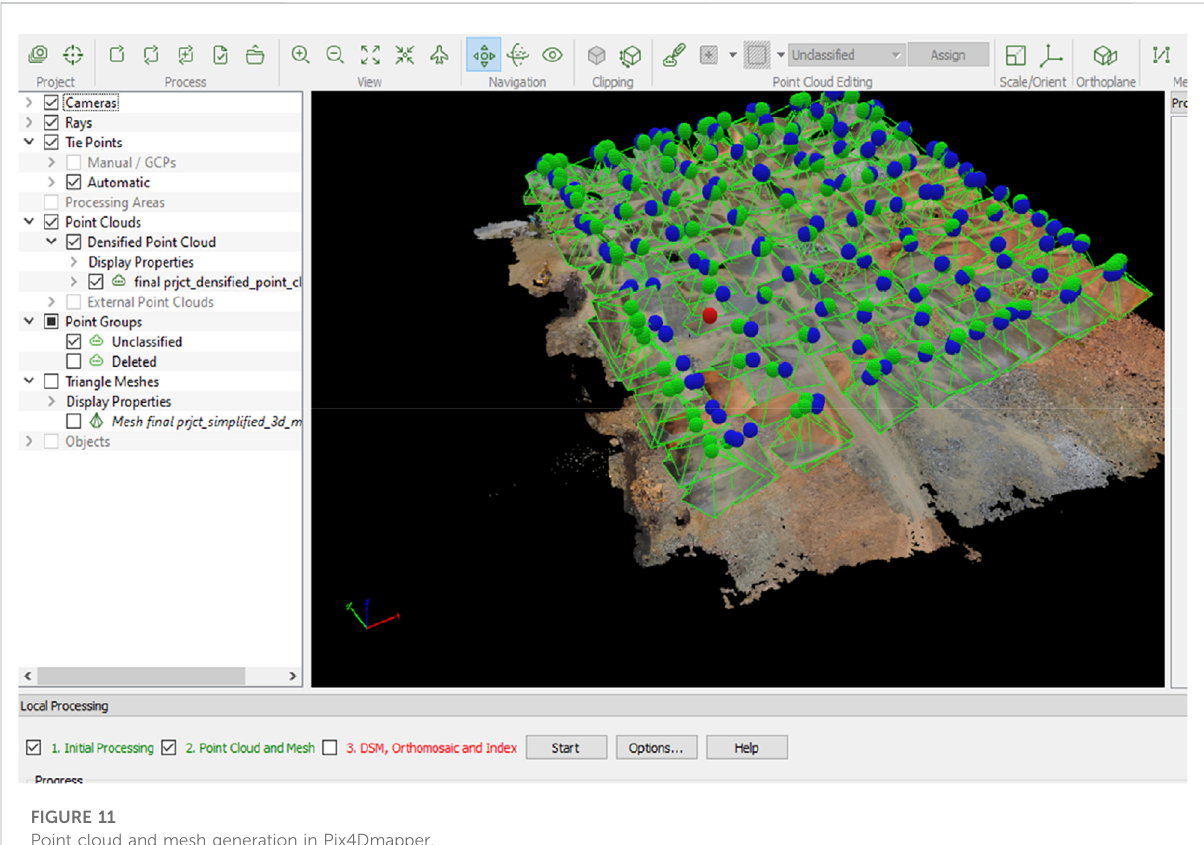
FIGURE 11 Point cloud and mesh generation in